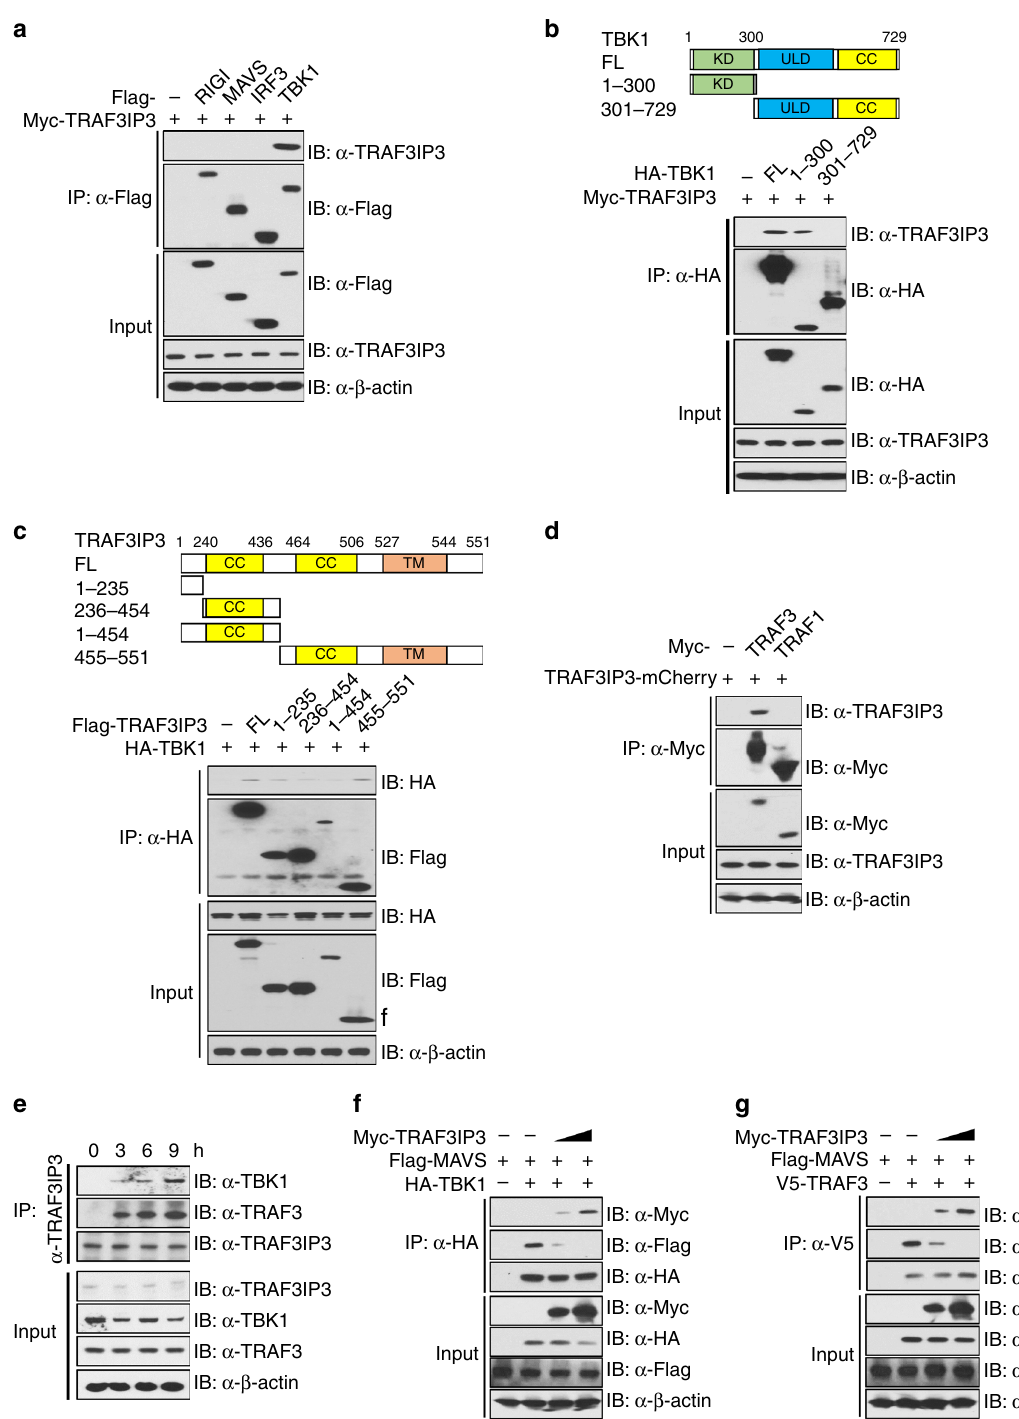
Fig. 5 TRAF3IP3 targets TRAF3 and TBK1. a – d Coimmunoprecipitation and immunoblotting using lysates from HEK293T cells transfected with the indicated expression vectors. e Immunoblotting of endogenous proteins with the indicated antibodies using lysates of THP-1 cells infected for various times with VSV (MOI = 1) followed by immunoprecipitation with anti-TRAF3IP3. f , g Coimmunoprecipitation and immunoblotting using lysates from HEK293T cells transfected with the indicated expression vectors. Data are one representative of at least three independent experiments. Source data are provided as a Source Data fi regulation of an innate anti-viral pathway in myeloid cells with both TRAF3 and TBK1 and prevented downstream signaling (Fig. 8). TRAF3IP3 reduced the IFN-I response by cytosolic RNA, transduction. Additionally, TRAF3IP3 promoted K43-linked which provided a clue linking TRAF3IP3 to the RLR pathway. polyubiquitination and degradation of TBK1. Importantly, abla- De fi ciency of TRAF3IP3 in both human and mouse cells poten- tion of Traf3ip3 led to enhanced anti-viral cytokine production tiated IFN-I induction by cytosolic RNA. TRAF3IP3 associated and viral clearance in vivo, underscoring its physiologic function.